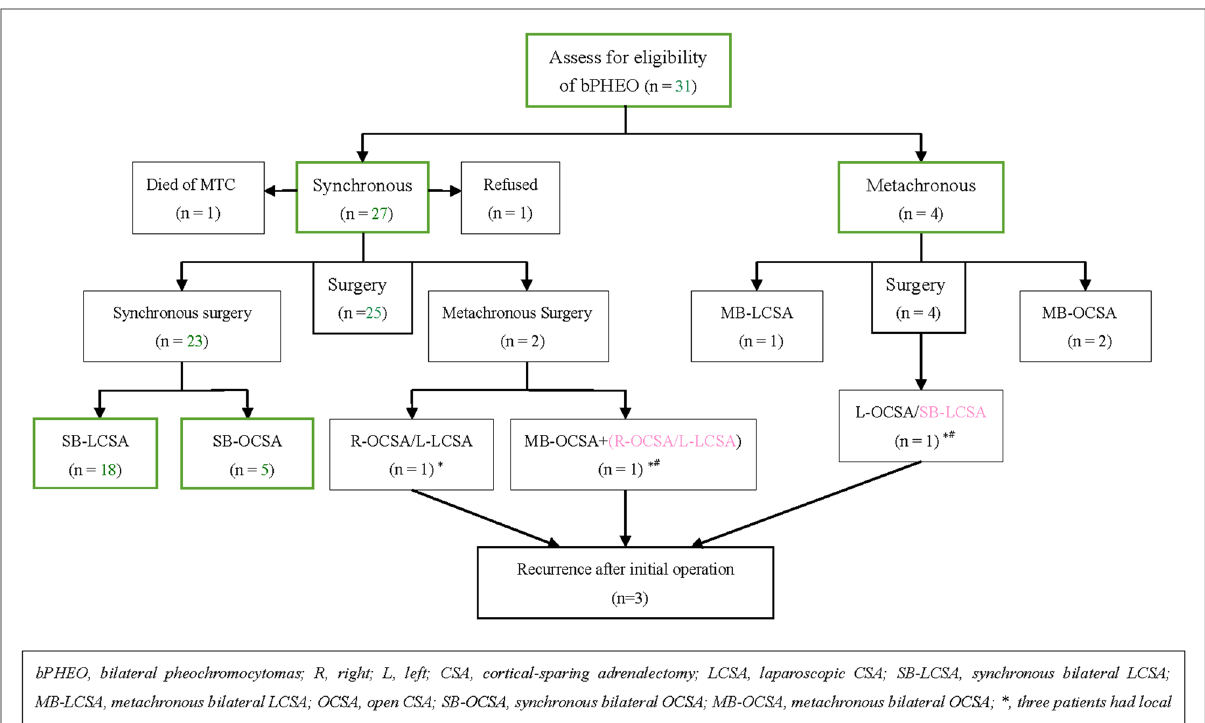
FIGURE 1 Study population and outcome by the type of operative intervention in those who had surgical